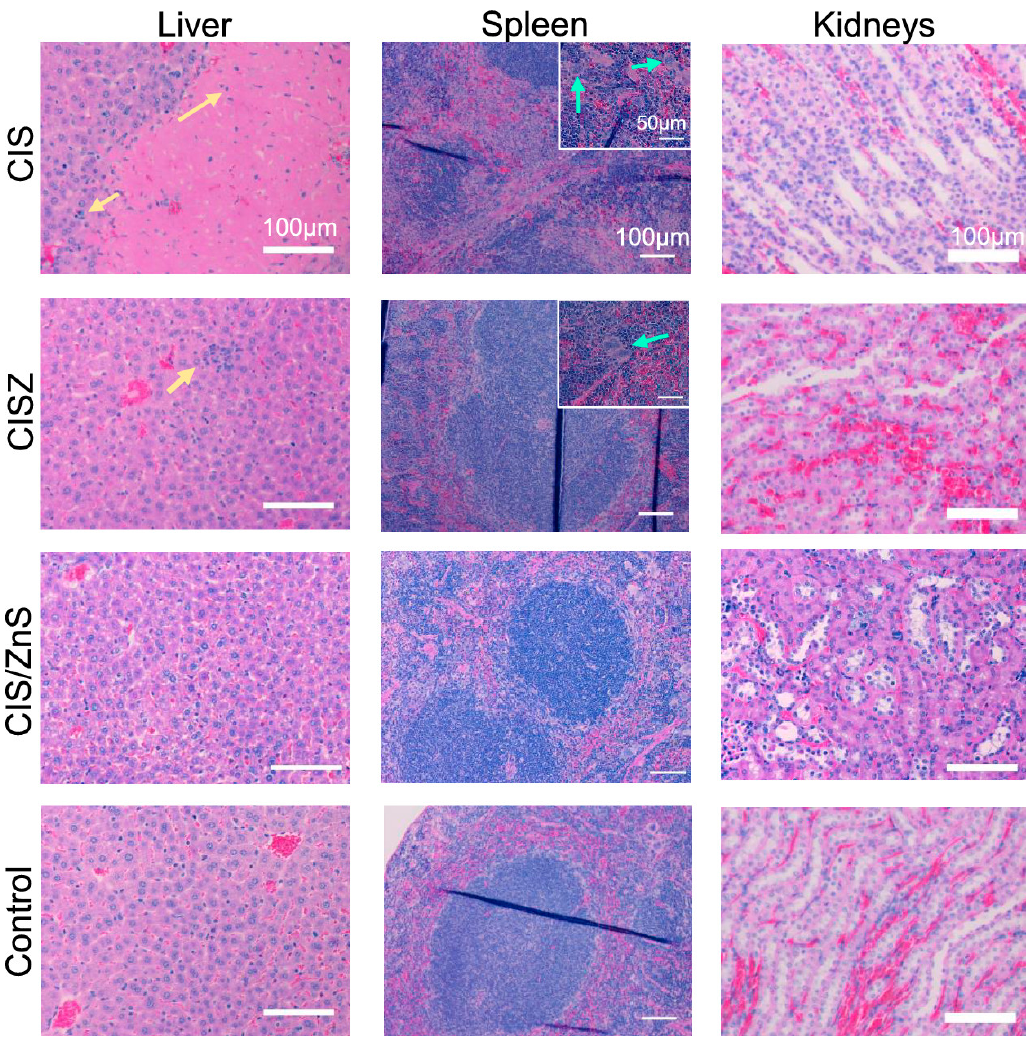
Figure 13. Histology of QD-dosed mice. Left, middle, and right columns show the liver, spleen, and kidney, respectively. Yellow arrows indicate inflammatory cells; blue arrows point to multinucleated giant cells. The scale bar is 100 μ m for primary photos and 50 μ m for inserts [101]. Pons et al. [102] synthesized CIS/ZnS QDs coated with dipalmitoyl phosphatidyl ethanolamine